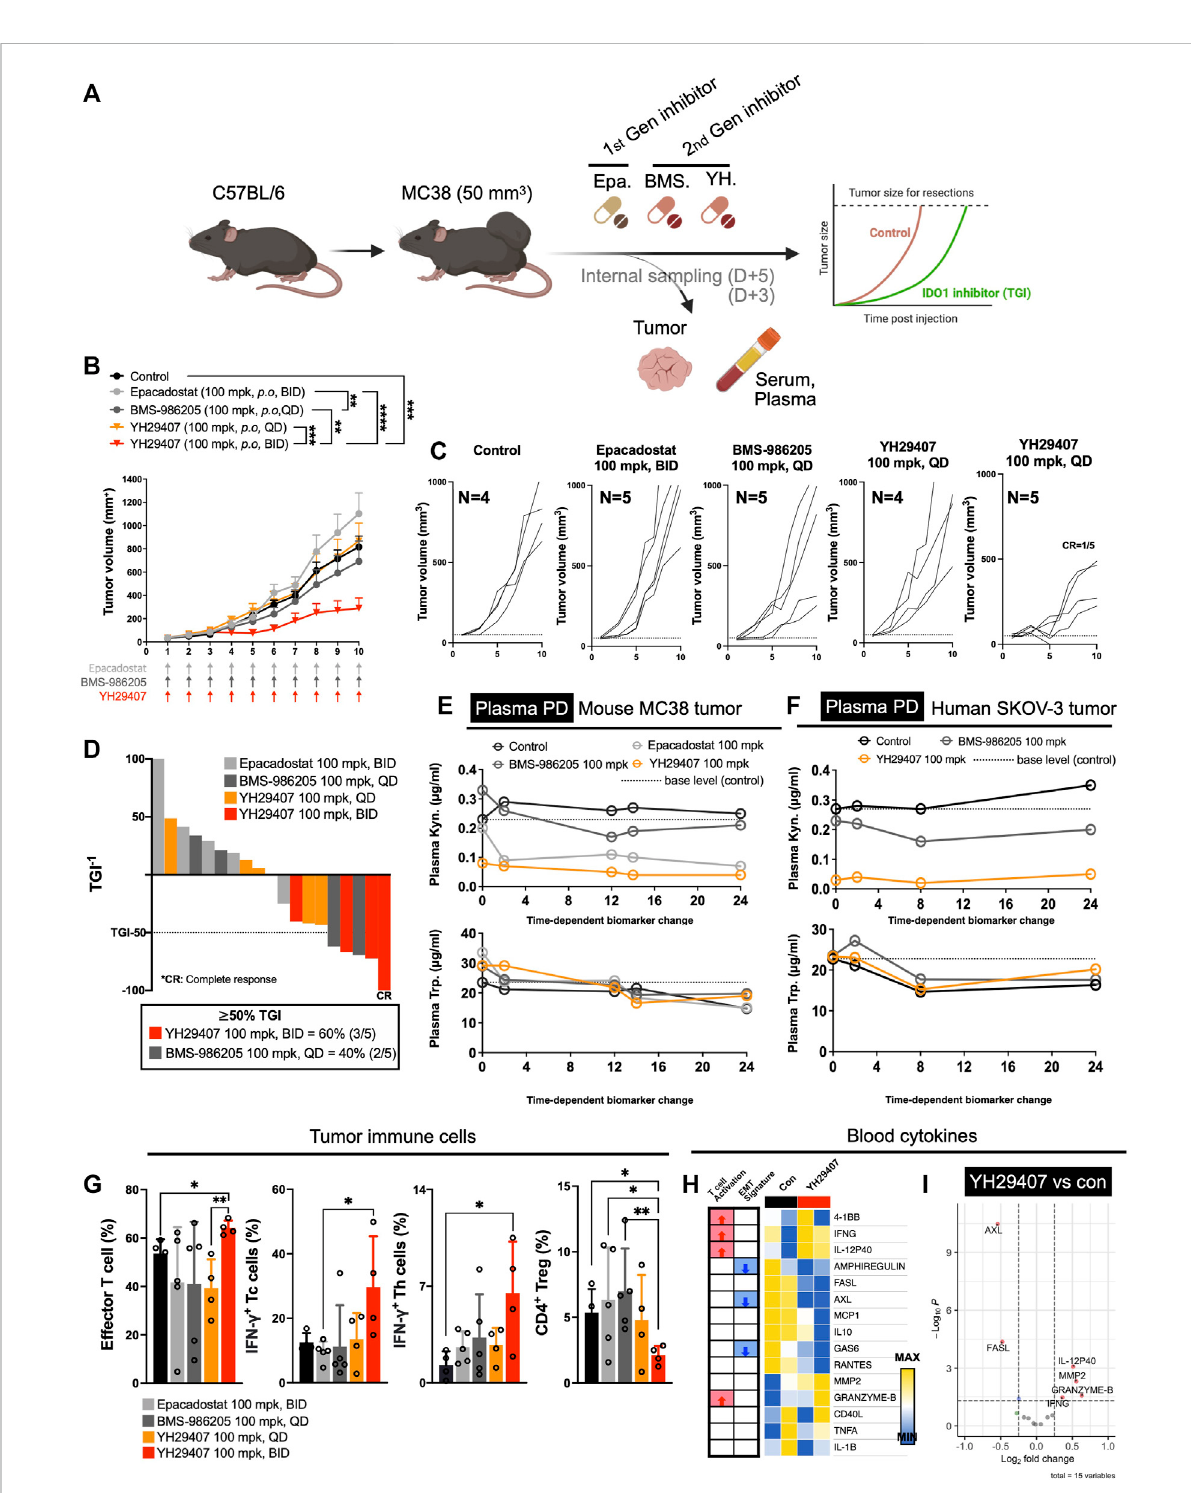
FIGURE 1 YH29407 with improved pharmacodynamics and pharmacokinetics reduced tumor growth via activation of the T cell-mediated immune response in a syngeneic MC38 tumor-bearing model. Syngeneic MC38 colon tumor was grafted onto C57BL/6 mice and treatment was started when the tumor volume reached 50 mm 3 . Epacadostat and BMS-986205 were treated as comparators, and tumor and serum were obtained after 5 days of treatment (A) . IDO1 inhibition with YH29407 (100 mg/kg, B.I.D.) signi fi cantly suppresses the growth of MC38 tumor in C57BL/6 mice compared to the comparator (B) . Tumor volume and number of individual mice (C) . Tumor growth inhibition was enhanced by the IDO1 inhibitor,